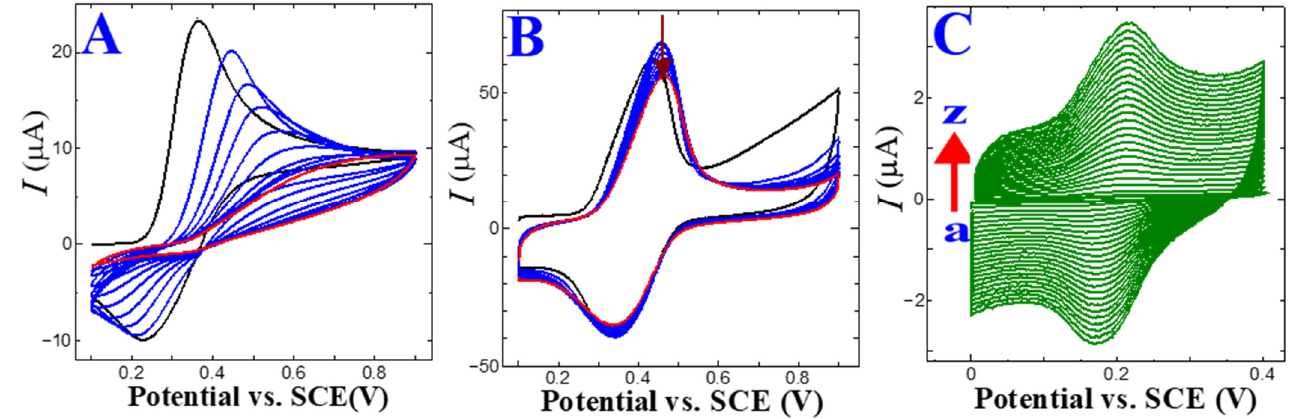
Figure 1. CV trace of electrochemical CFA (2 mM) polymerization at a scan rate of 20 mV s −1 and pH 4.0 (0.2 M PBS) on ( A ) bare glassy carbon and ( B ) ERGO/GC (black line: first cycle, blue lines: second to ninth cycles, red line: 10th cycle). ( C ) CV trace of a p-CFA@ERGO/GC-coated electrode at various scan rates from 5 to 600 mV s − 1